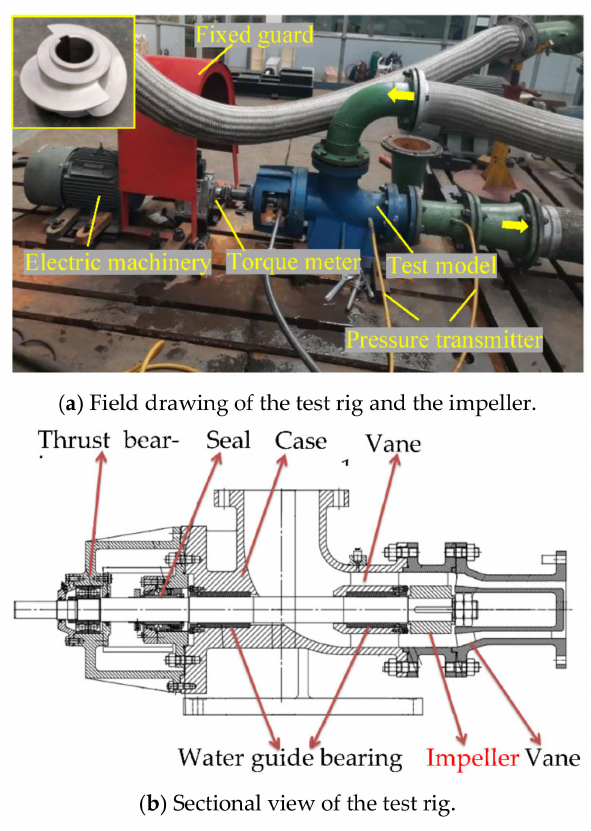
Figure 4. The test rig was used to validate the numerical approach.